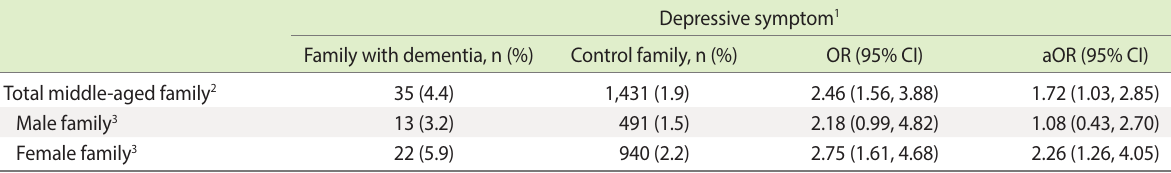
Table 3. OR for PHQ-9 detected depressive symptom between family with dementia patients at home and control family